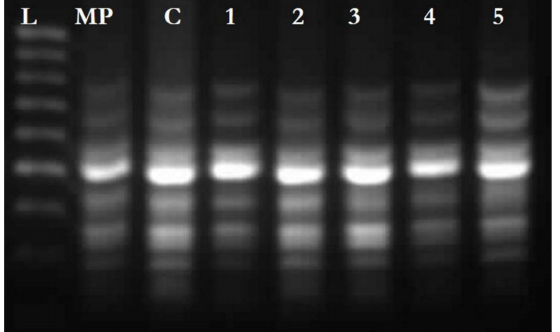
Figure 7. A band pattern produced by UBC 17 primer: Ladder (L), Mother plant (MP), control (C) and M. oblongifolia shoots exposed to ZnO NPs treatments (1, 2, 3, 4 and 5) represent ZnO NPs treatment 1.25, 2.5, 5, 10, and 20 mg/L,